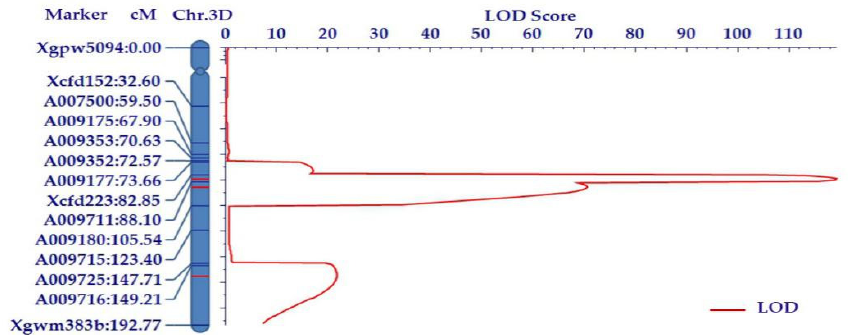
Figure 2. Linkage groups assigned to the chromosome arms 3DL in the chromosomal segment substitution lines (CSSL) of Zhoumai 18 and T093. DNA markers and their positions are shown along the chromosome arms. The distance between adjacent markers is given in the cM units of Kosambi. The threshold logarithm of the odds (LOD) is 2.61. Table 1. Quantitative trait loci (QTL) peak location, left and right markers, LOD values, phenotypic variation explained (PVE), and additive effect of QTL on chromosome 3DL estimated in the F 2 population in 2016. Chromosome QTL QTL